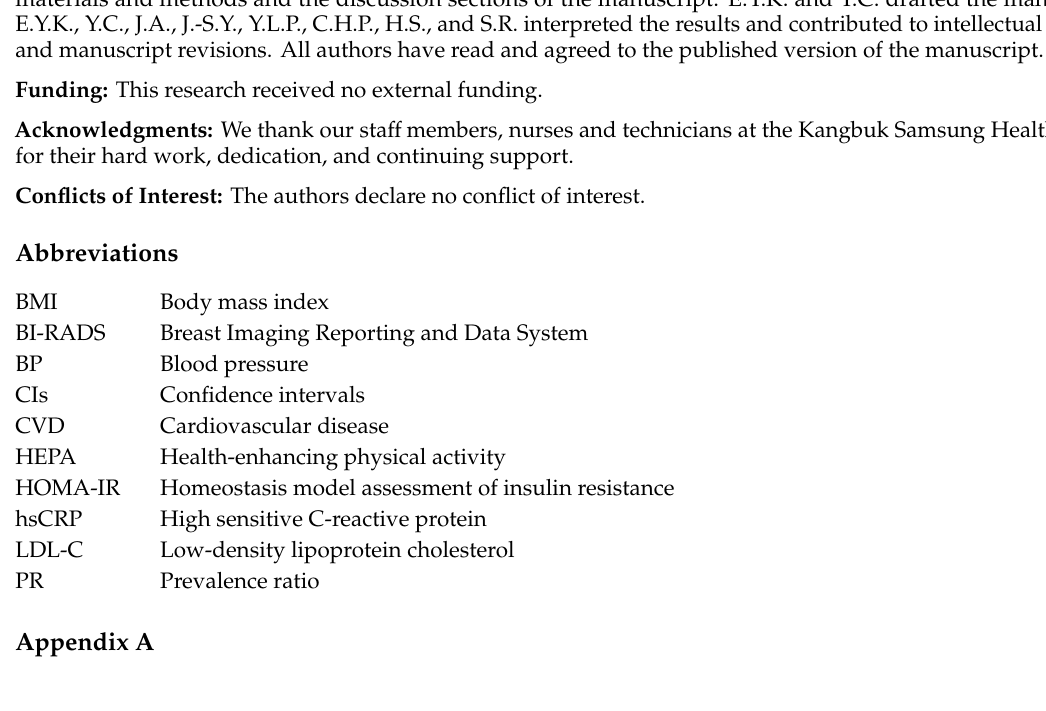
Table A1. Dense-breast prevalence according to menopausal stage among never, former and current smokers ( n =